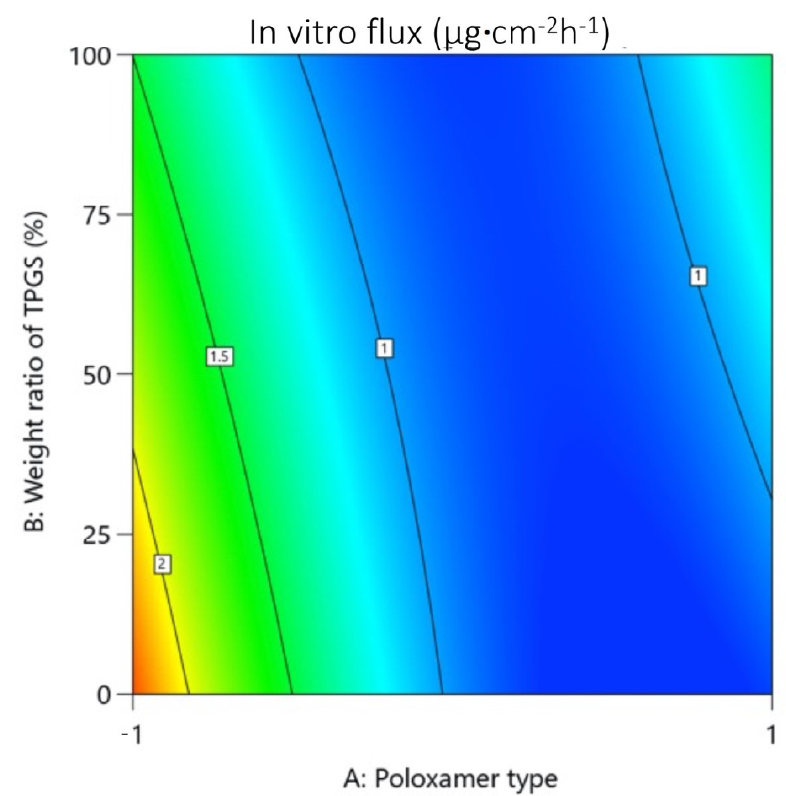
Figure 7. Contour plot showing relative effect of poloxamer type and weight ratio of TPGS on rapamycin in vitro flux.